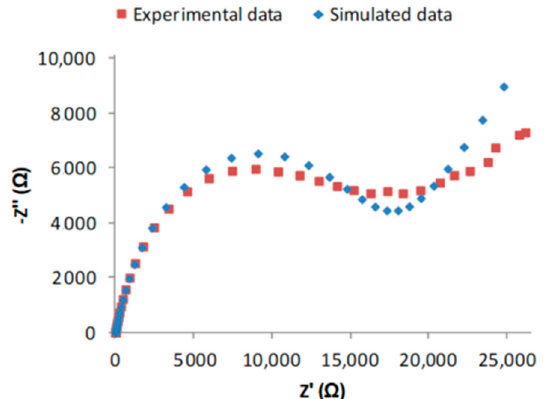
Figure 5. Nyquist plot of the data for Cu electrode in acid aqueous solution of H 2 SO 4 0.1 M, modified with self-assembled monolayer of octylphosphonic acid (6 h) together with the fit resulting from the Randles circuit in Figure 4.